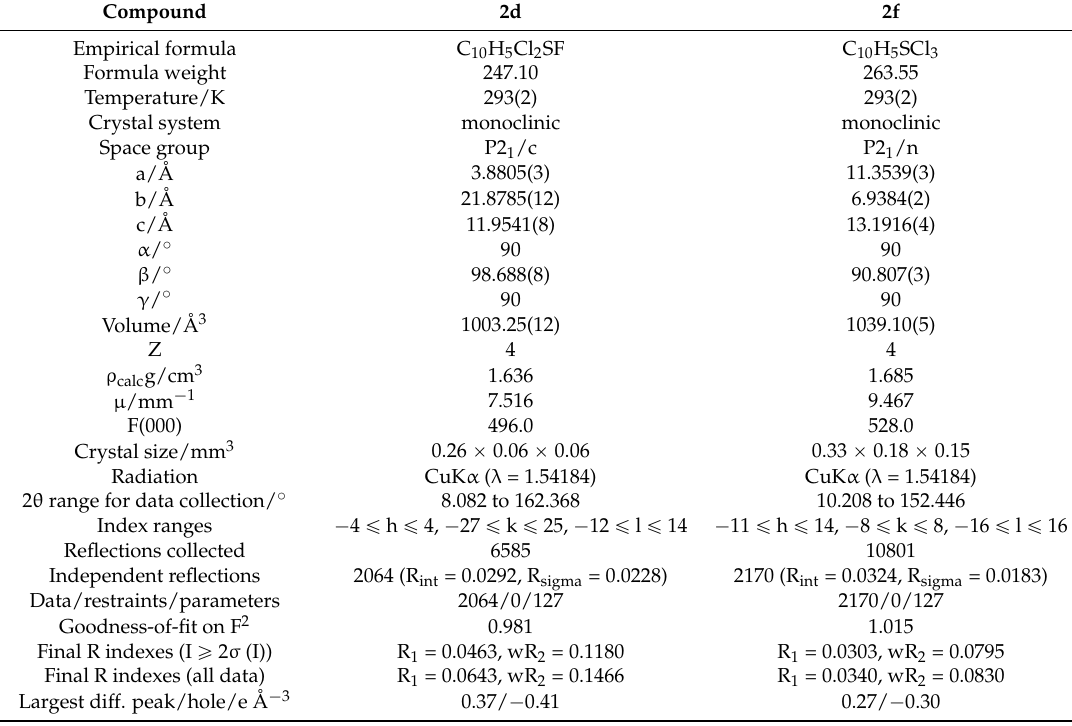
Table 1. Crystal data and structure refinement parameters for compounds 2d and 2f .